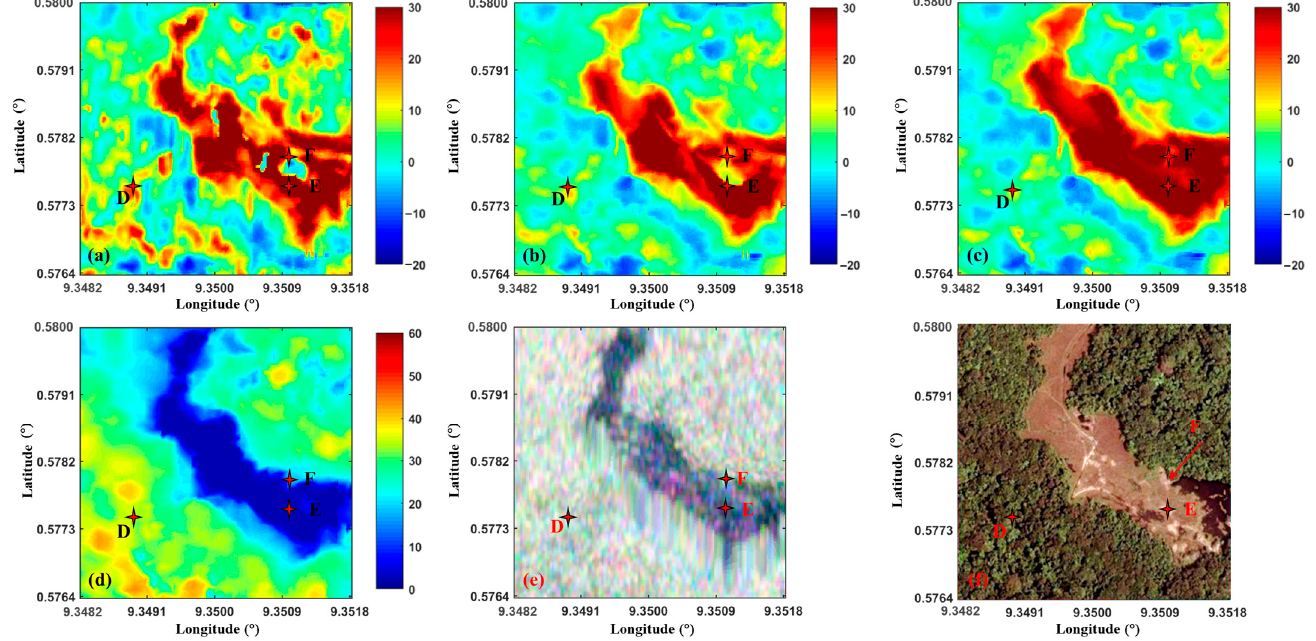
Figure 5. Estimation error of forest height results under three sizes and LiDAR forest height results in Mondah: ( a ) 5 × 5 size; ( b ) 11 × 11 size; ( c ) 25 × 25 size; ( d ) LiDAR forest height; ( e ) PauliRGB images; ( f ) optical image.